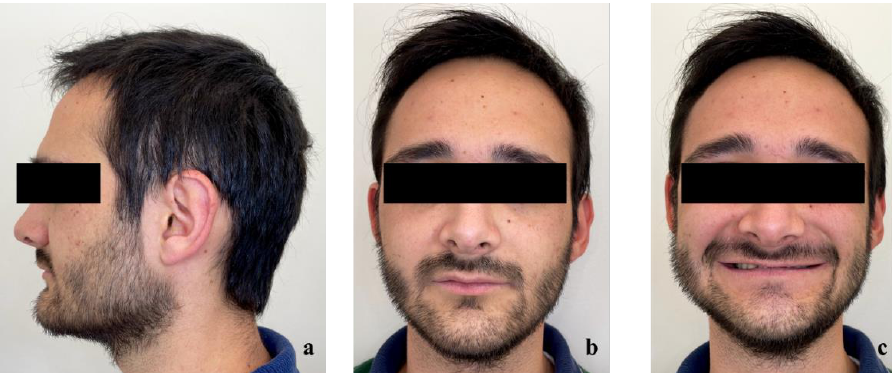
Figure 1. Extraoral examination: ( a ) profile view, ( b ) front view, ( c ) front view forced smile. Endobuccal clinical assessment revealed dental agenesis of the upper left and right lateral incisors and lower left and right central incisors, generalized small teeth size, infil- trated maxillary grooves, and an amalgam restoration on the occlusal surface of the lower left second molar. Occlusal analysis showed complete overbite, a left unilateral articular inversion on the two upper left molars, an Angle Class I canine and molar on the right side and an Angle Class II canine and molar on the left side. In addition, the anterior over- hang is reduced, so the patient is in class II division 2.